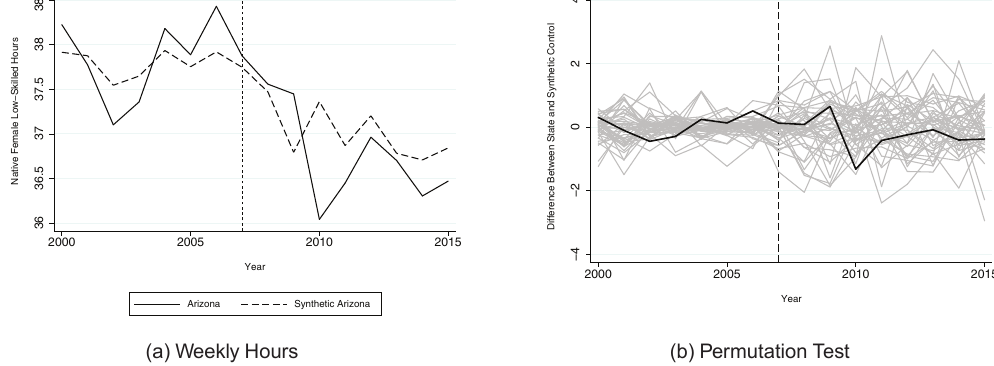
Figure 6 Native low-skilled female weekly hours (hours >